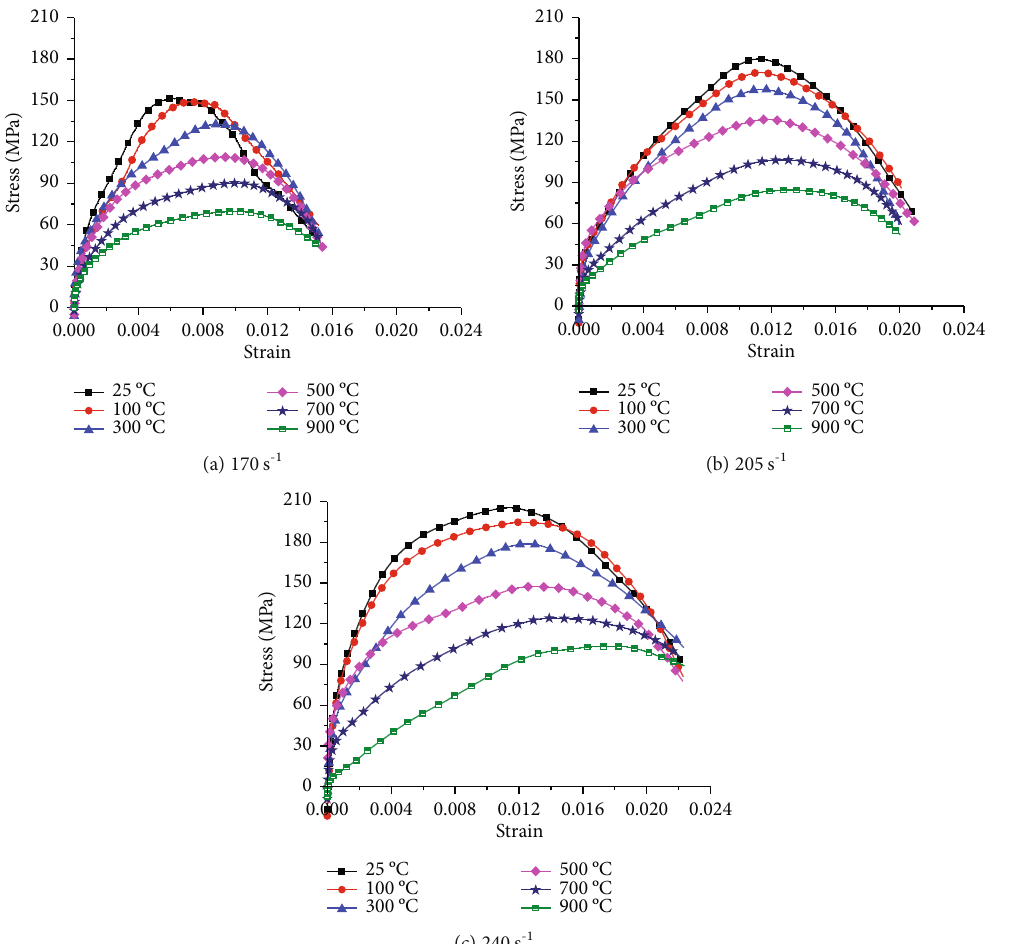
Figure 3: Dynamic stress-strain curves of deep sandstone with various strain rates.